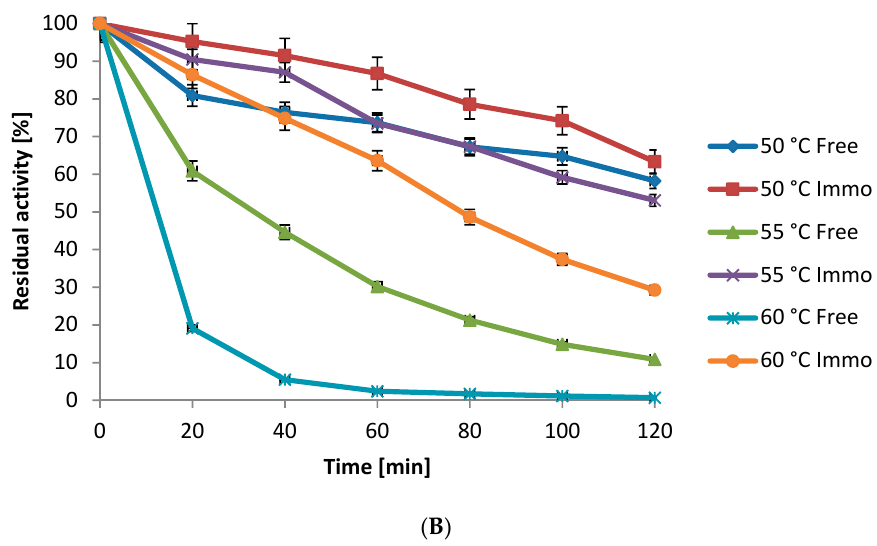
Figure 7. Effect of temperature on activity ( A ) and stability ( B ) of free and immobilized NPST-AK15 protease. Protease activity was measured under the standard assay conditions at various temperatures (30–75 °C) at pH 10. For thermal stability, the enzyme was pre-incubated at different temperatures for 2 h at pH 11.0, and the residual enzyme activities were estimated at regular intervals under standard assay conditions. The non-heated enzymes were taken as 100%. The results represent the mean of three separate experiments, and error bars are indicated.